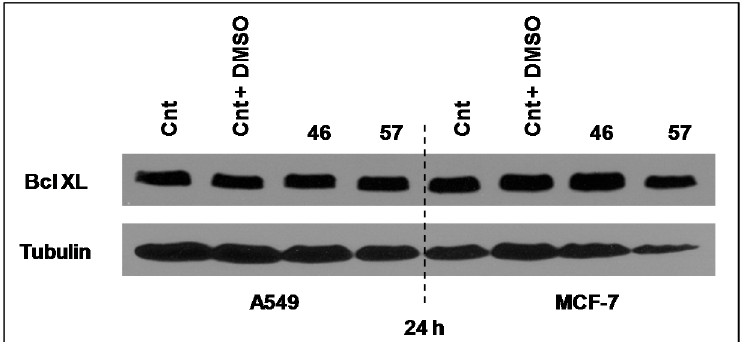
Figure 10. Extracts #46 and #57 do not appear to alter the expression levels of Bcl-XL in MCF-7 and A549 cells.